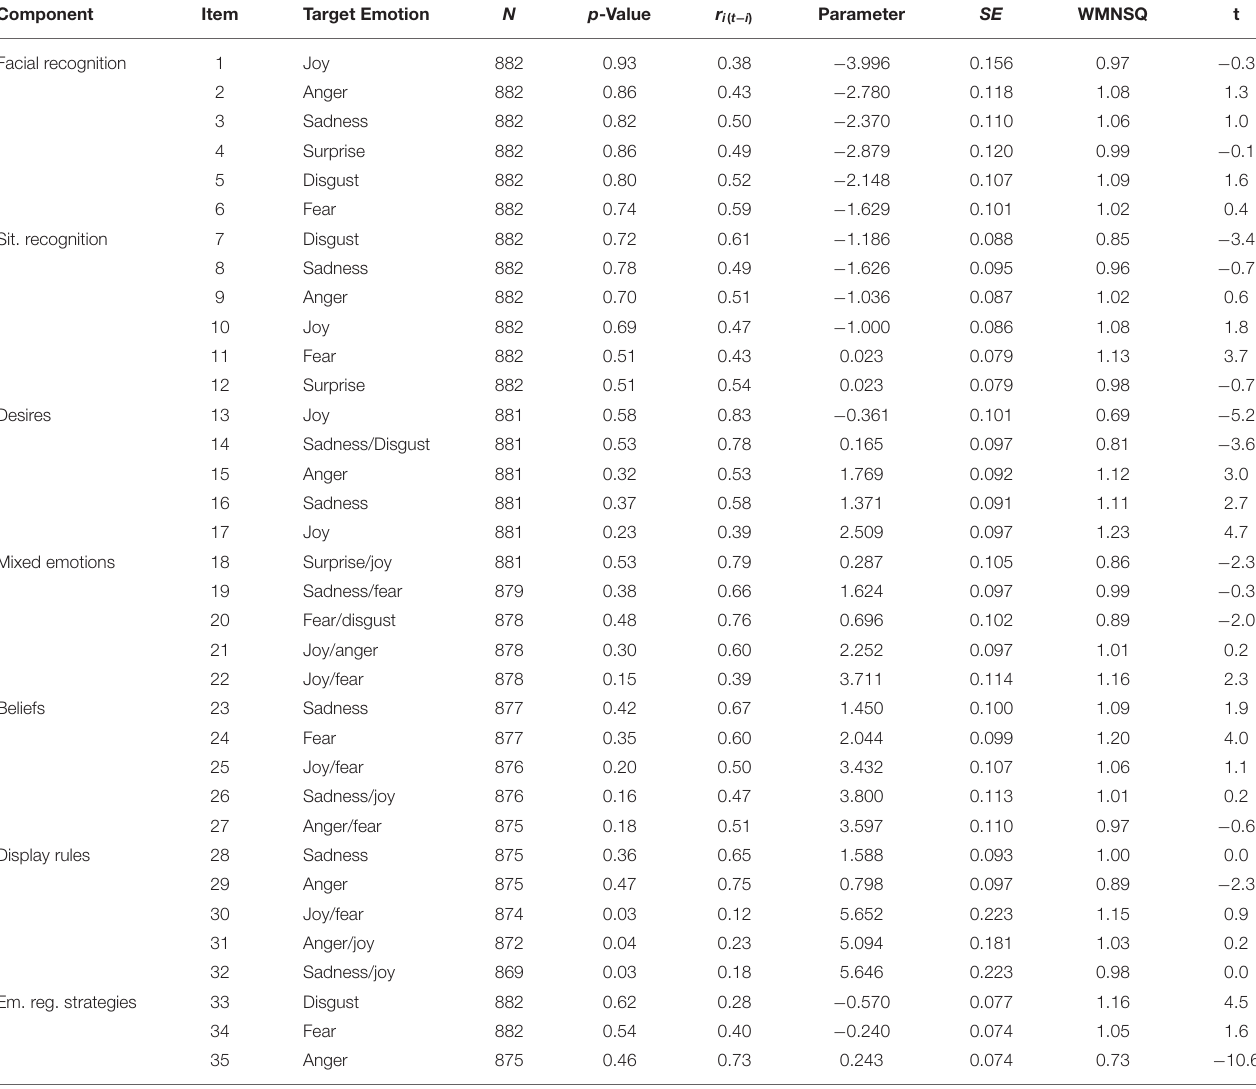
TABLE 5 | Item characteristics of the ATEM